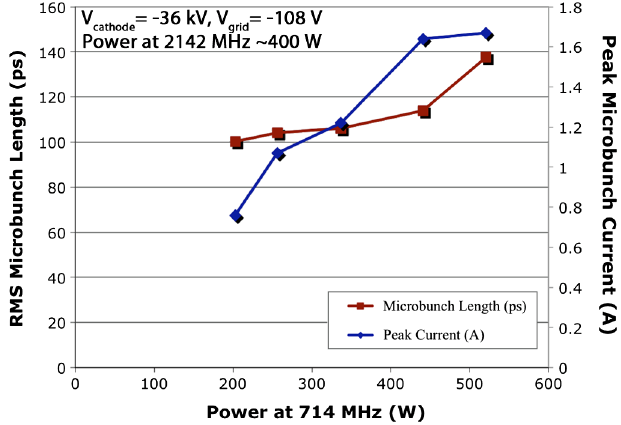
FIG. 9. Peak current and microbunch length versus power at 714